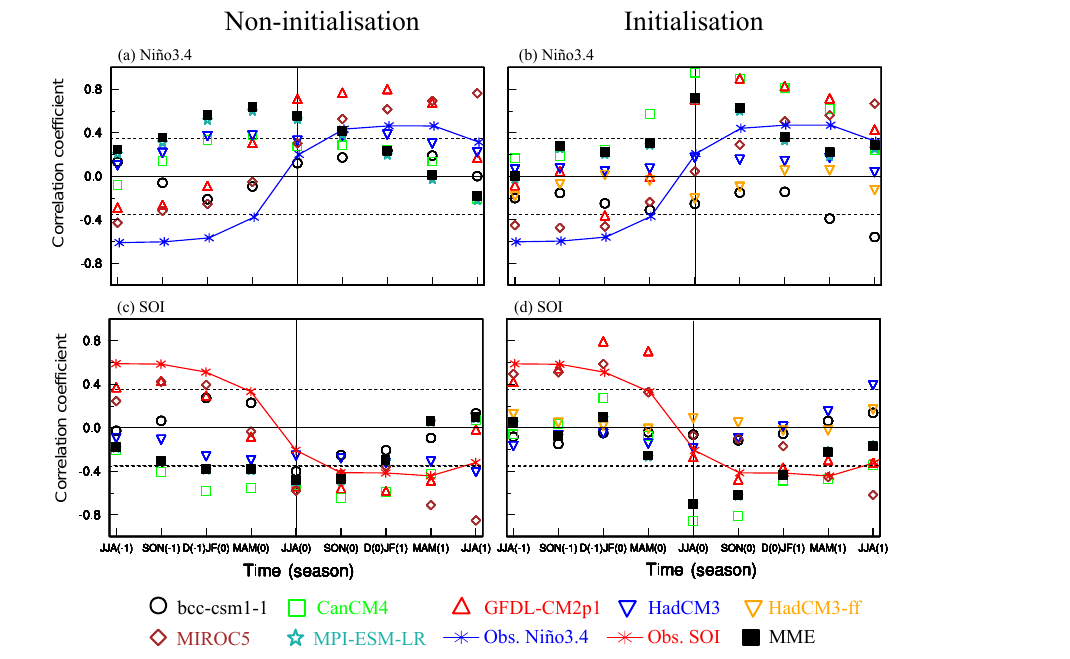
Figure 8. Lead–lag correlation coefficients between the EASM index and Niño3.4 (a) , as well as SOI (c) in non-initialised simulations (a,c) and initialised ones (b, d) for observation (marker line) and models (marker) from JJA( − 1) to JJA( + 1). The two black dotted lines are the 0.05 significance level based upon a Student’s t test. The vertical line represents JJA(0), where the simultaneous correlations between the EASM index and Niño3.4, as well as SOI are